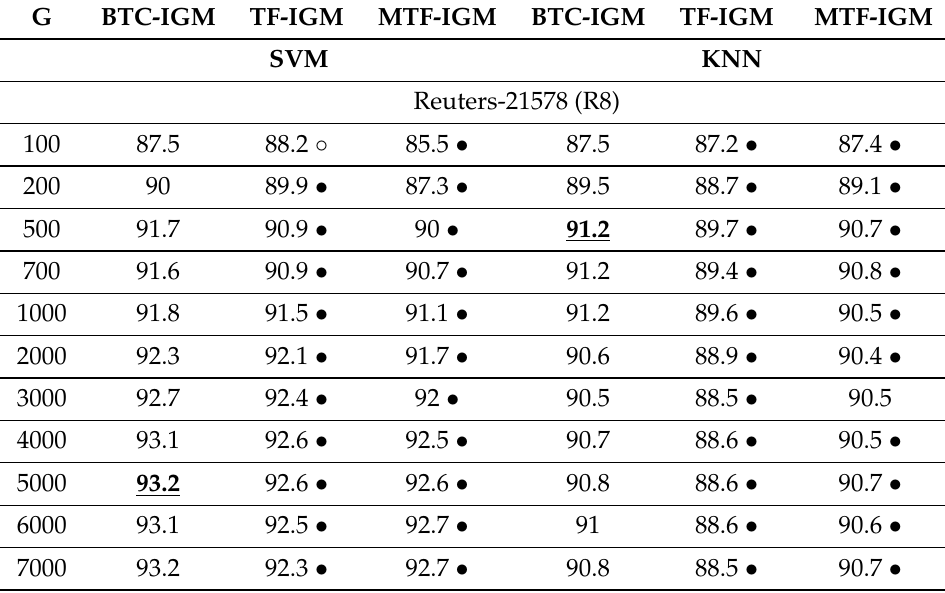
Table 7. Performance comparison of BTC-IGM vs TF-IGM vs